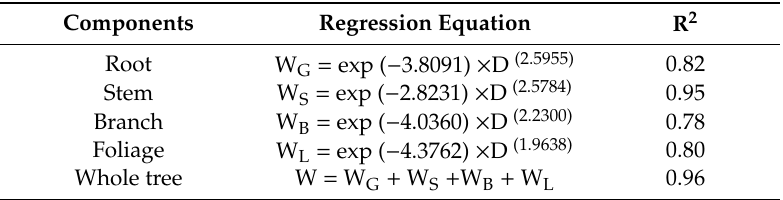
Table 3. Individual biomass regression model of larch forest.